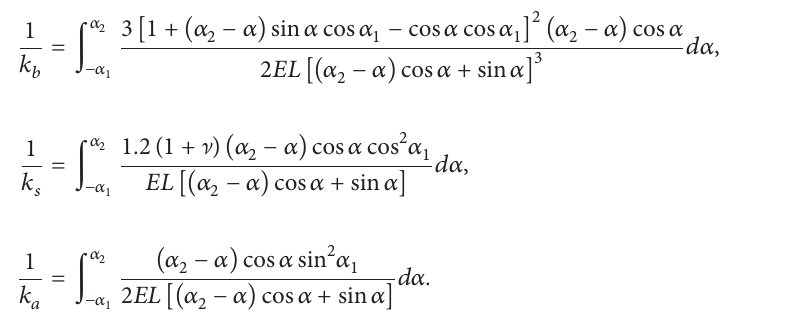
angle is 𝛼 1 . ℎ 𝑐 represents the vertical distance between the tip of the crack and the tooth’s central line, which corresponds to the angle 𝛼 𝑔 . 𝑅 𝑏 is the radius of base circle. 𝛼 2 is the